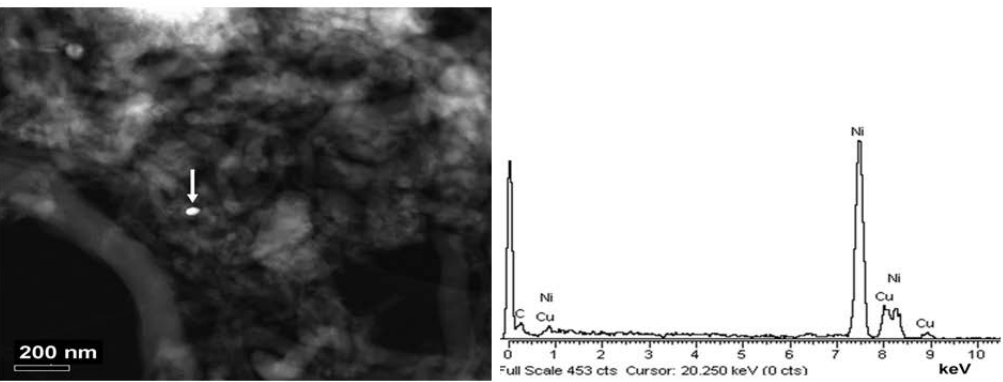
Figure 2. An example of an annual dark field scanning transmission electron microscopy (ADF-STEM) image of sample CNF D, dry powder. The energy dispersive X-ray spectroscopy (EDS) spectrum of the indicated metallic particle is given to the